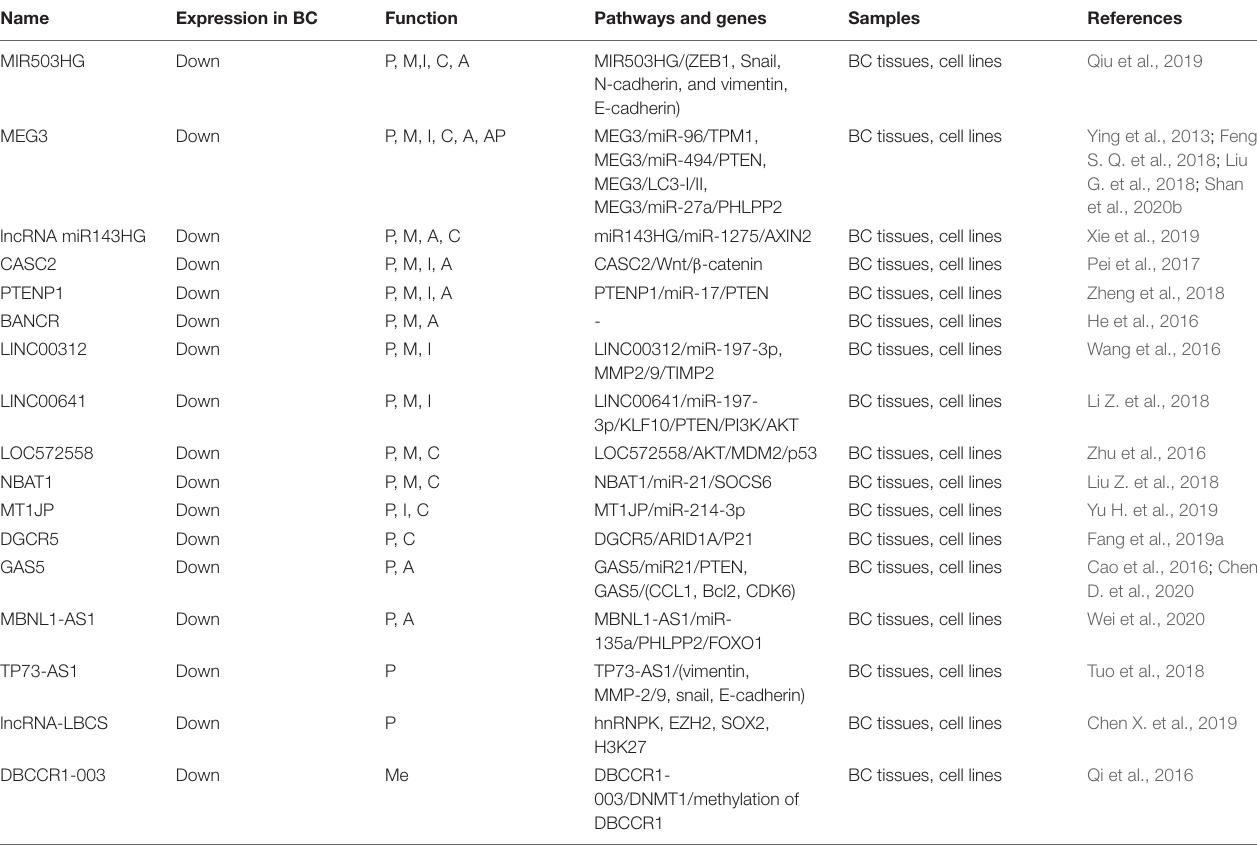
TABLE 2 | Downregulated expression, function and related gene or signaling pathway of lncRNAs in